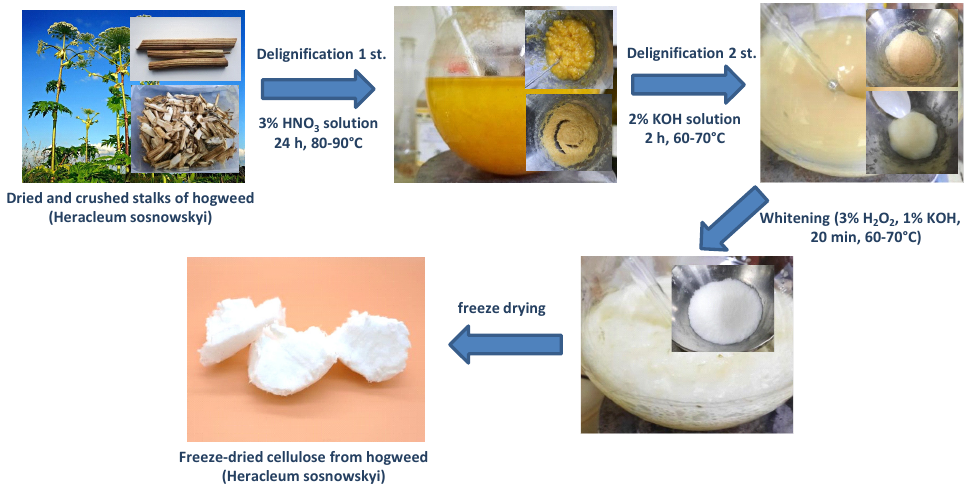
Figure 1. Scheme of obtaining cellulose from the stalk of hogweed. Film Preparation Technique. An aqueous suspension of cellulose HogC (concentration 20 g/L) was mixed well. The resulting mixture was poured into a 200 × 100 mm glass mold and leveled off to prevent perimeter film thickness fluctuations. After three days, the dried film was separated from the mold.